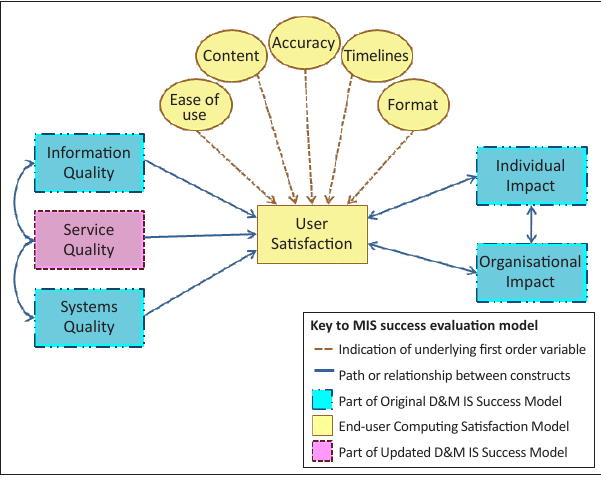
FIGURE 4: Proposed management information systems Success Evaluation